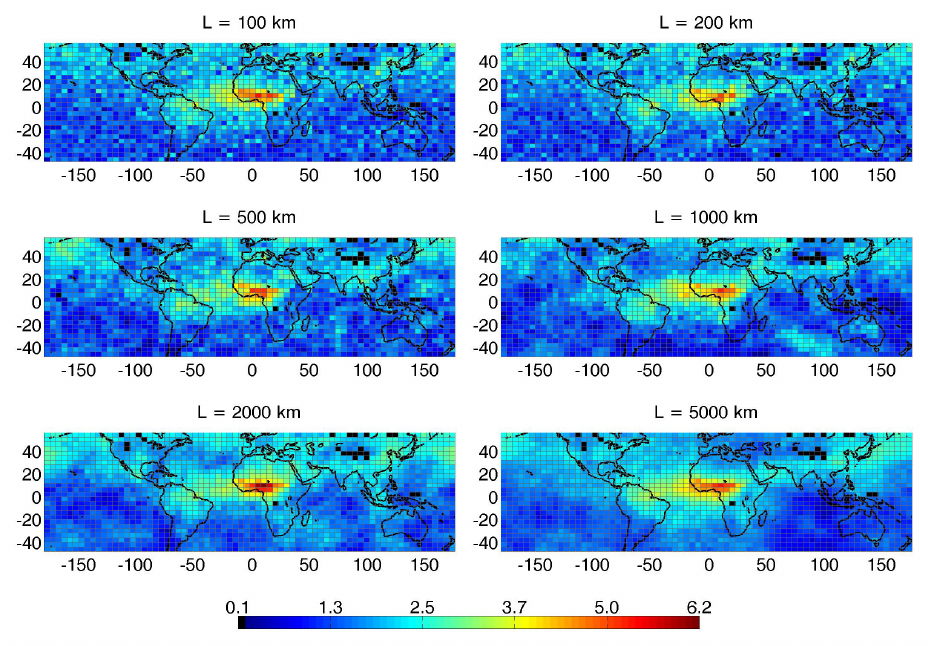
Fig. 4. Spatial images of synthetic MOPITT CO column measurements ˜ y (in units of 10 18 moleculesCOcm − 2 ) corresponding to the errors in Fig. 3. The black cells represent missing